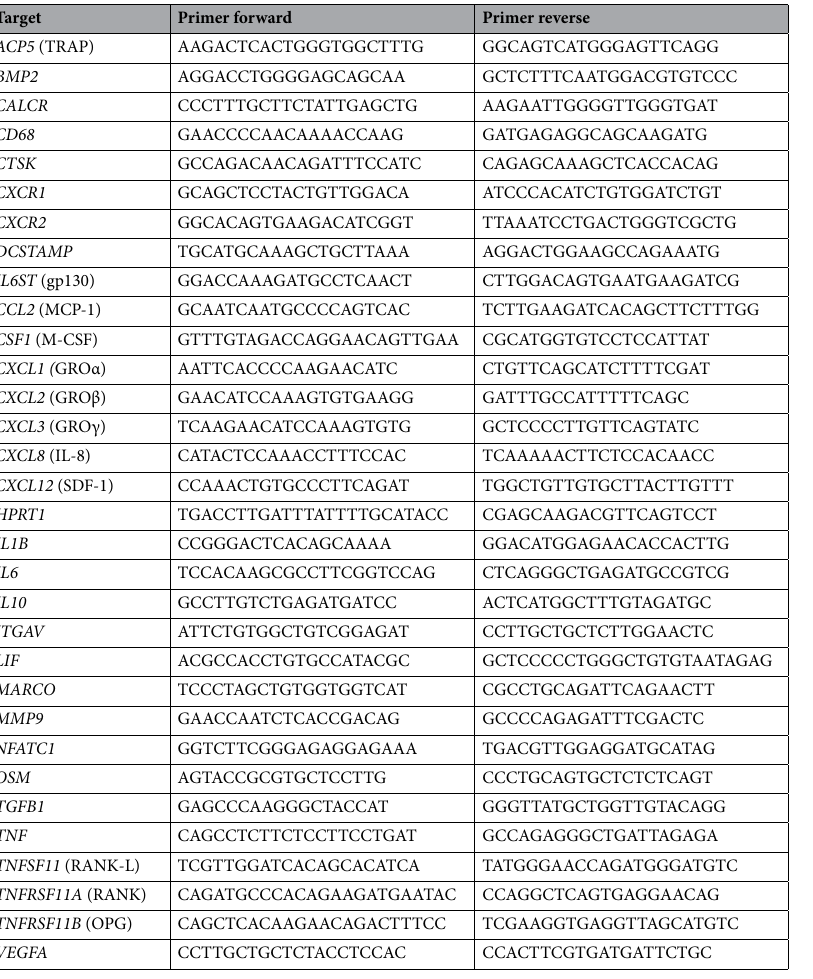
Table 1. List of primers used for RT-qPCR